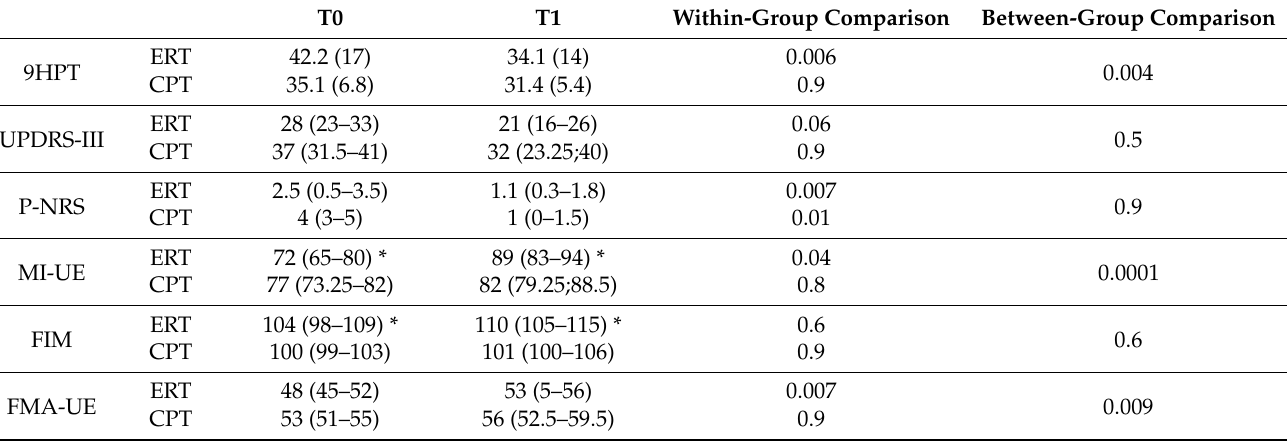
Table 2. Outcome measure scores at T0 (baseline) and T1 (post-treatment) in the ERT ( n = 15; * n = 12) and CPT ( n = 9) group. Data are reported as mean (SD) or median (interquartile range), and p -value of within-group (using t -test or Wilcoxon test) and between-group comparison (using t -test or Mann–Whitney